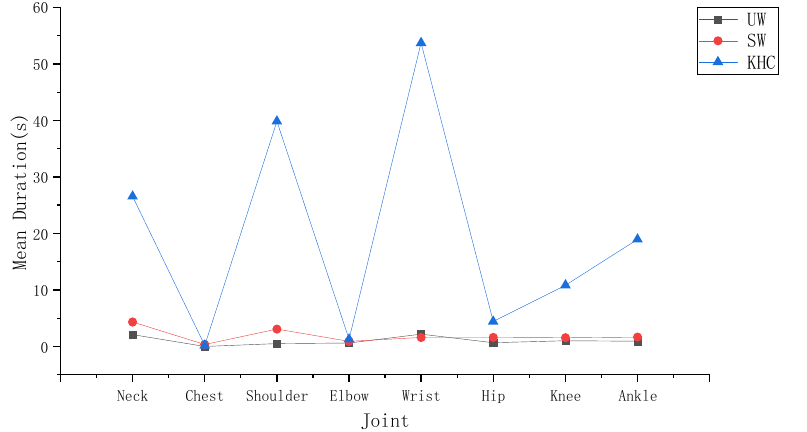
Figure 6. The mean joint duration. UW—upright walking; SW—stoop walking; KHC—knee and hand crawling.